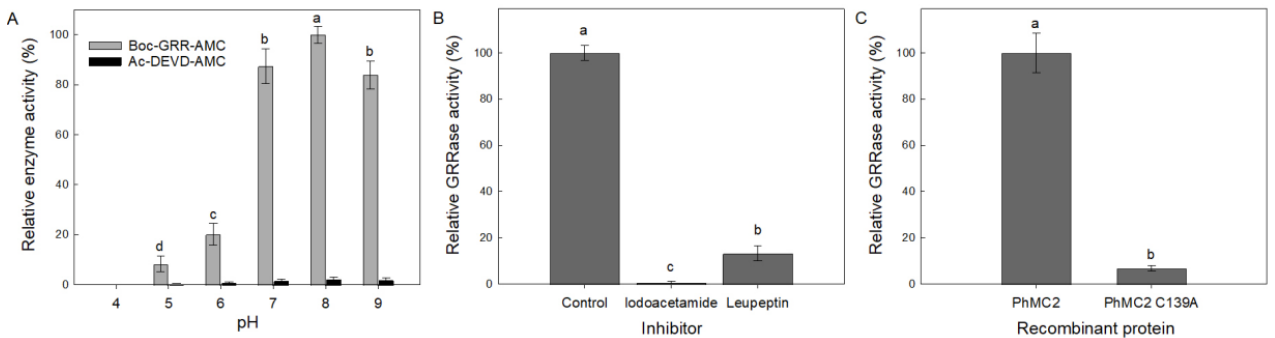
Figure 2. Enzyme activity of PhMC2. ( A ) Substrate specificity of rPhMC2 was determined using the fluorogenic protease substrate Boc-GRR-AMC and the fluorogenic caspase substrate Ac-DEVD-AMC at various pH. ( B ) The activity of rPhMC2 against Boc-GRR-AMC (GRRase activity) at pH 8.0 in the presence of the cysteine protease inhibitor, iodoacetamide, or the arginal protease inhibitor, leupeptin. ( C ) GRRase activity of rPhMC2 and the mutant metacaspase PhMC2 C139A (catalytic cysteine converted to alanine) at pH 8.0. Relative enzyme activity is the percentage of the activity compared to the highest activity. All data are the means of three replicates ± SE ( n = 3). Different letters represent statistically significant difference between the means ( p ≤